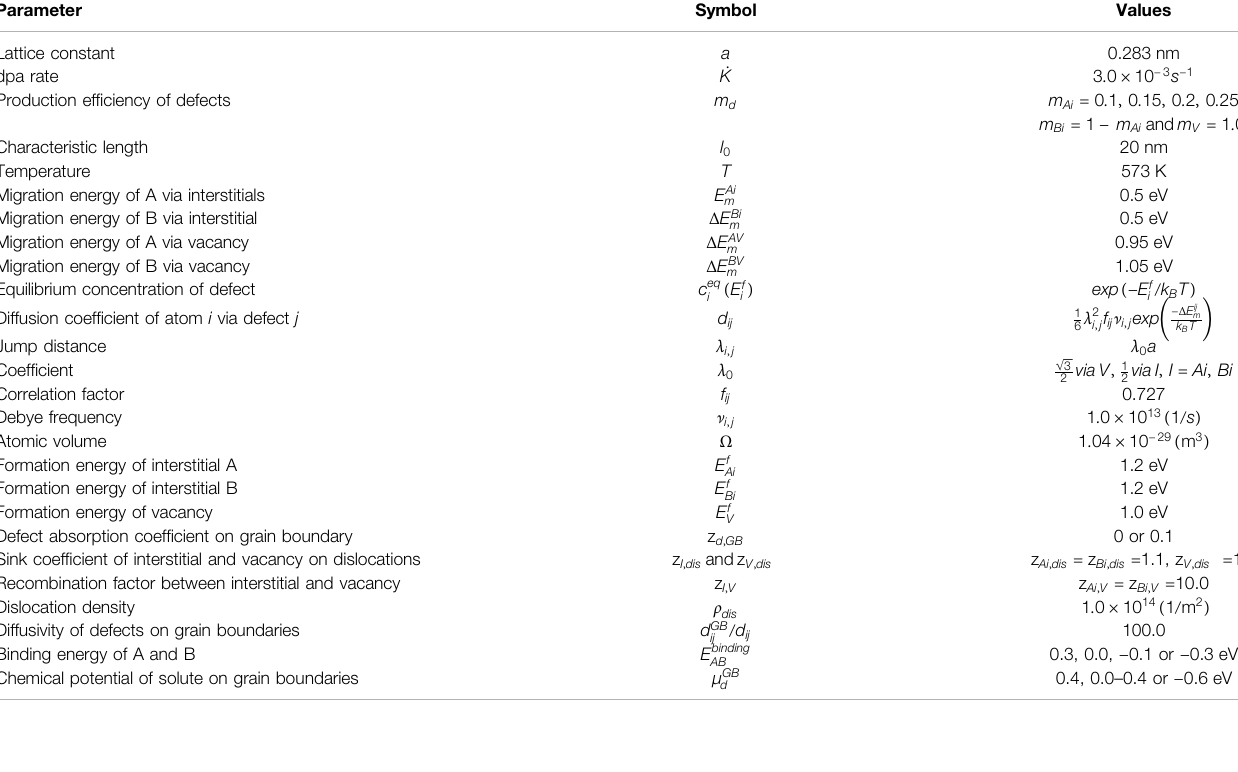
TABLE 1 | Parameters for the ABVI model system named by Huang and Marian (2016) and Was (2016). Parameter